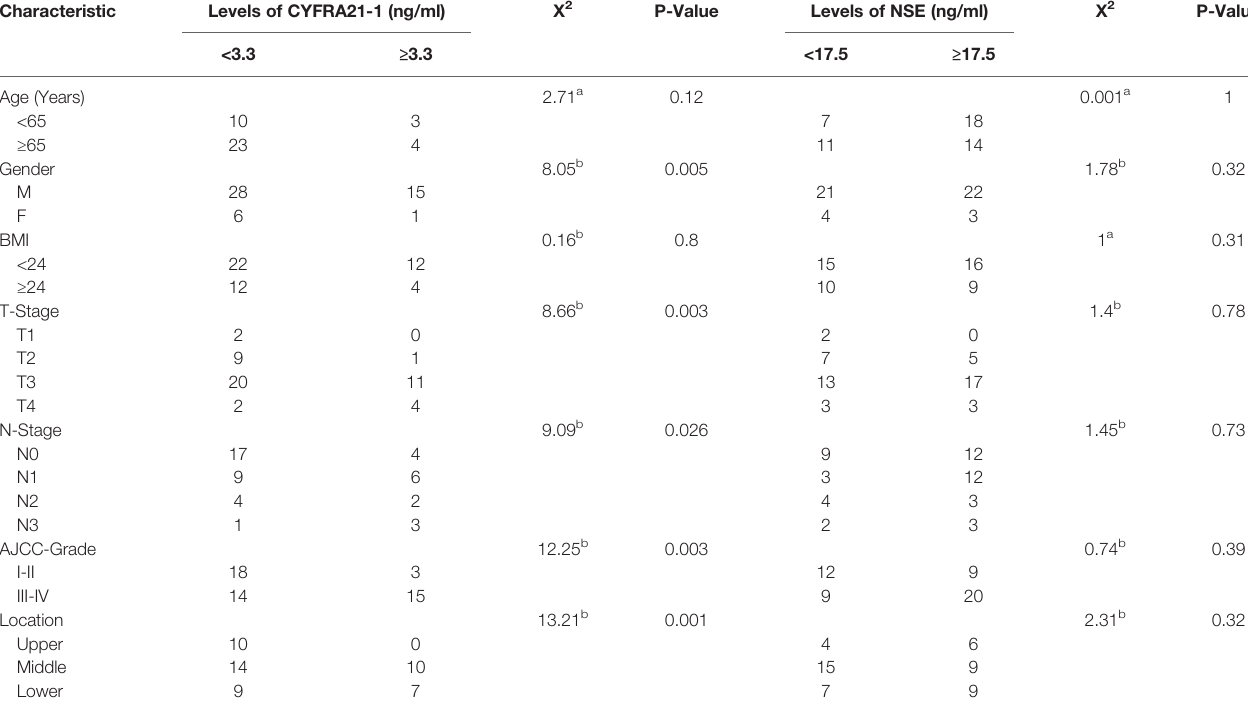
TABLE 3 | Assessment of plasma tumor markers ’ levels by multivariate analysis. Characteristic